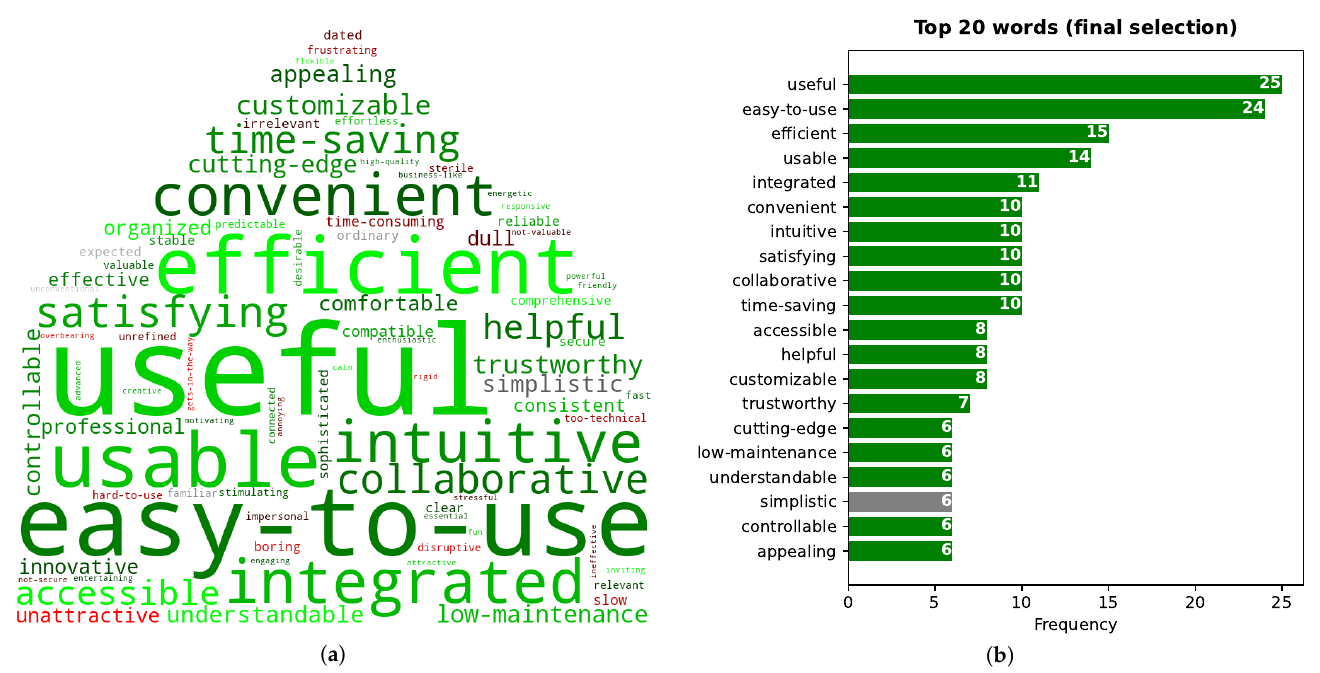
Figure 11. Word cloud considering all chosen words ( a ) and word frequency (i.e., number of times a word was chosen) considering only the twenty more frequently chosen words (top 20) ( b ) for the final word selection of the 118-word test. In the word cloud, a larger font size means that the word was selected by more participants (higher